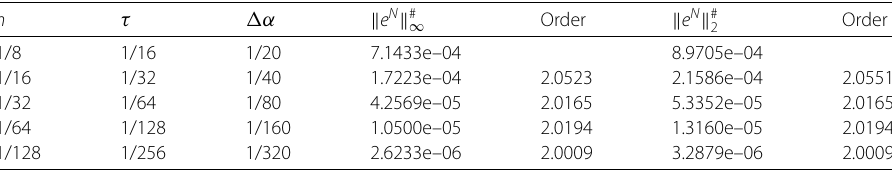
Table 2 The discrete L 2 errors, maximum errors, and convergence rates for scheme (8) for Example 1 with v 1 = 0.1 and v 2 =